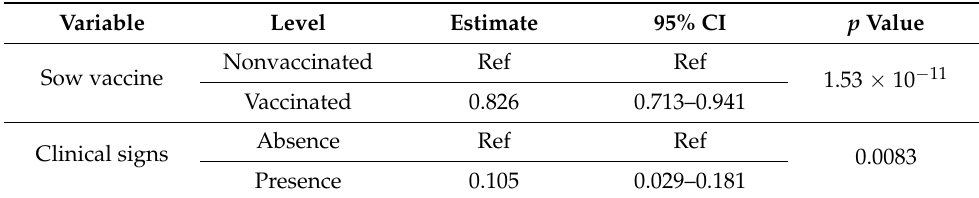
Figure 2. Levels of IgG against F4 in samples from sows ( A ) and their piglets ( B ). ( A ), Two sows were vaccinated (black symbols) with F4 at 4 (day − 32) and 2 (day − 12) weeks before farrowing. Two sows remained unvaccinated as control (white symbols). Serum samples at vaccination times, farrowing (D0) and at weaning (3 weeks after farrowing) (as well as colostrum samples) were tested for F4 antibodies using ELISA. ( B ), Serum samples from piglets nursed by vaccinated (black circles) or nonvaccinated (white circles) sows taken at 1, 2, 3 and 5 weeks of life were tested for F4 antibodies by ELISA. At 22 days of life, piglets were challenged with G. parasuis . The average absorbance in the ELISA is shown in the graph. Error bars represent the standard deviation. Individual piglet results can be found in Figure S1. Table 1. Final model with the association of the log 10 transformed ELISA values against F4 and predictor variables using generalized additive